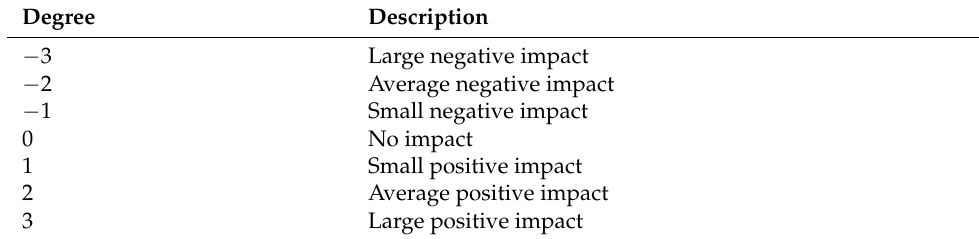
Table 8. Assessment